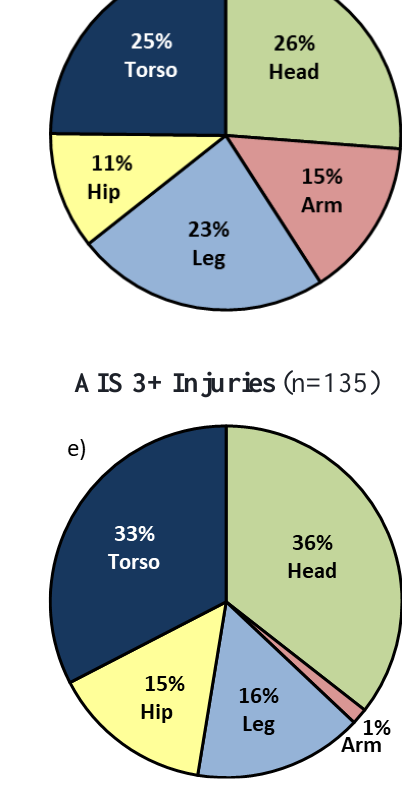
Figure A3. Injured body parts based on: all injuries in a) VRU and b) car/truck/bus collision accidents; AIS 2+ injuries in c) VRU and d) car/truck/bus collision accidents; AIS 3+ injuries in e) car/truck/bus collision